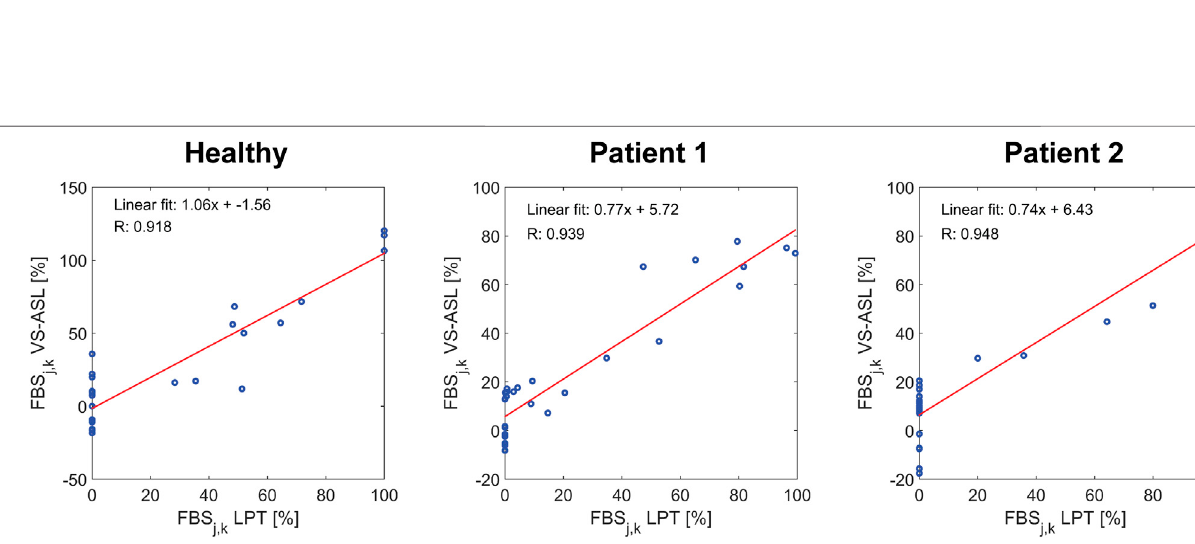
Frontiers in Bioengineering and Biotechnology |